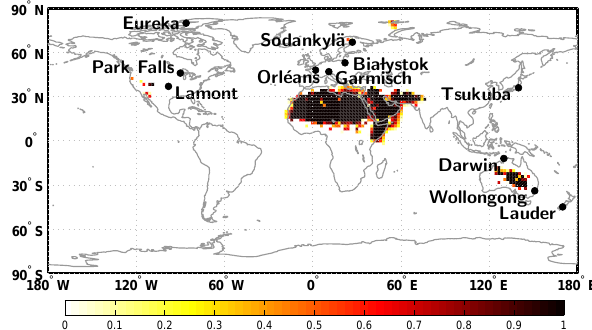
Fig. 1. The locations of the TCCON stations used in this study are shown in black circles. The fraction of soundings in a 2° by 2° box that are M-gain (and removed) are shown in the colours. The darkest shaded regions indicate that all the soundings in that region are measured with M gain (e.g., northern Africa, parts of central